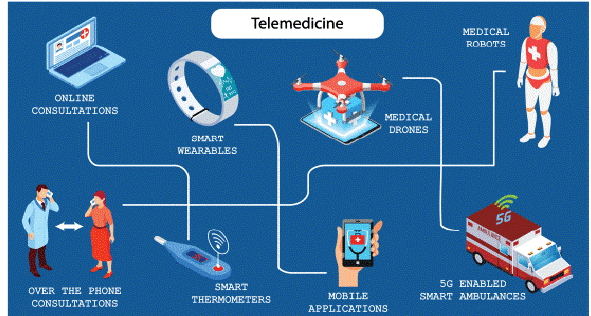
Figure 1. Various technologies enabling telemedicine